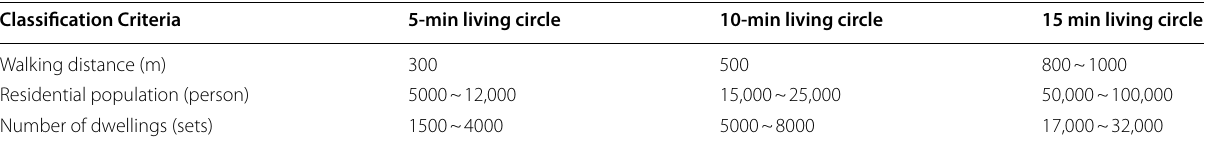
Table 4 Different categories of living circles